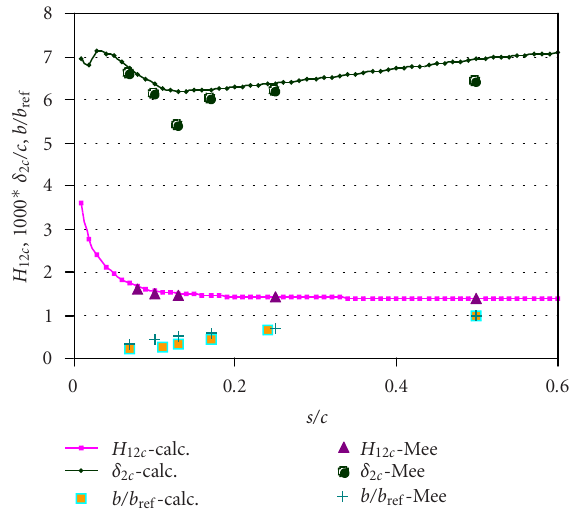
Figure 3: Comparison of prediction and test data: compressible form factor H 12 c , wake width b/b ref , and momentum thickness δ 2 c /c for the cascade tested by Mee et al.